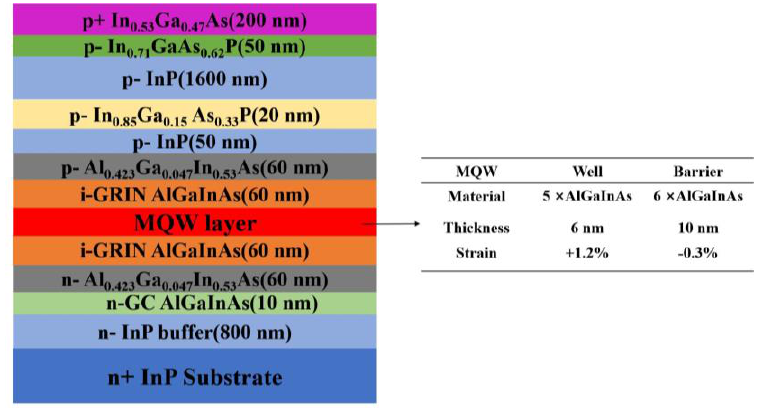
Figure 1. The epitaxial layer structure of the PMC.